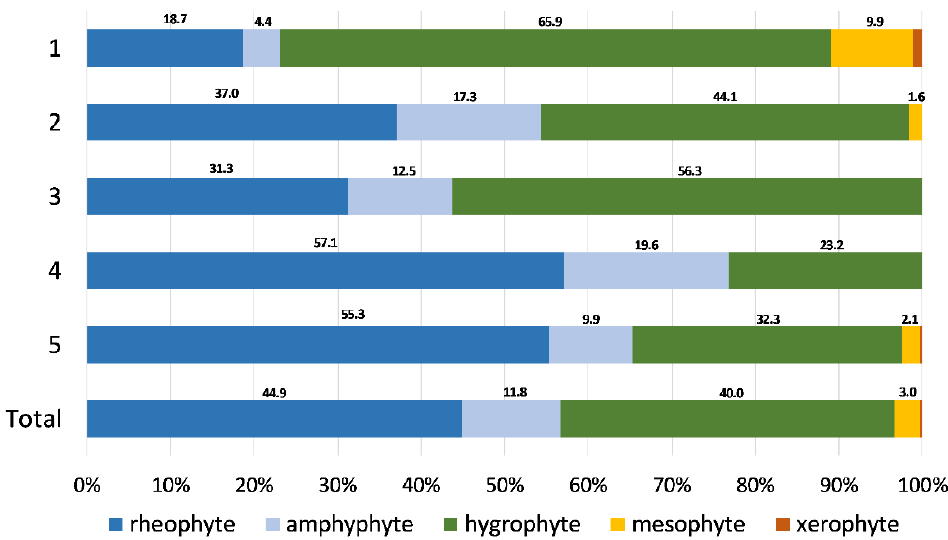
Figure 3. Bryophyte affinity to water for TWINSPAN groups and a total sample of 76 bryophyte- dominated sites.